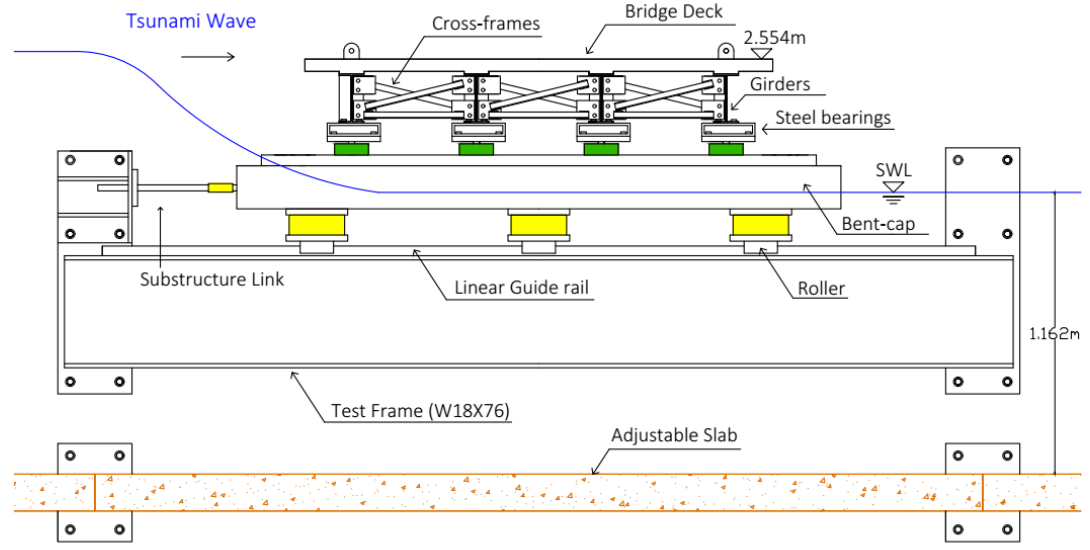
Figure 4. Cross-section of the experimental setup at the bridge location depicting the main structural components and load cells of the test case with steel bearings and rigid link.